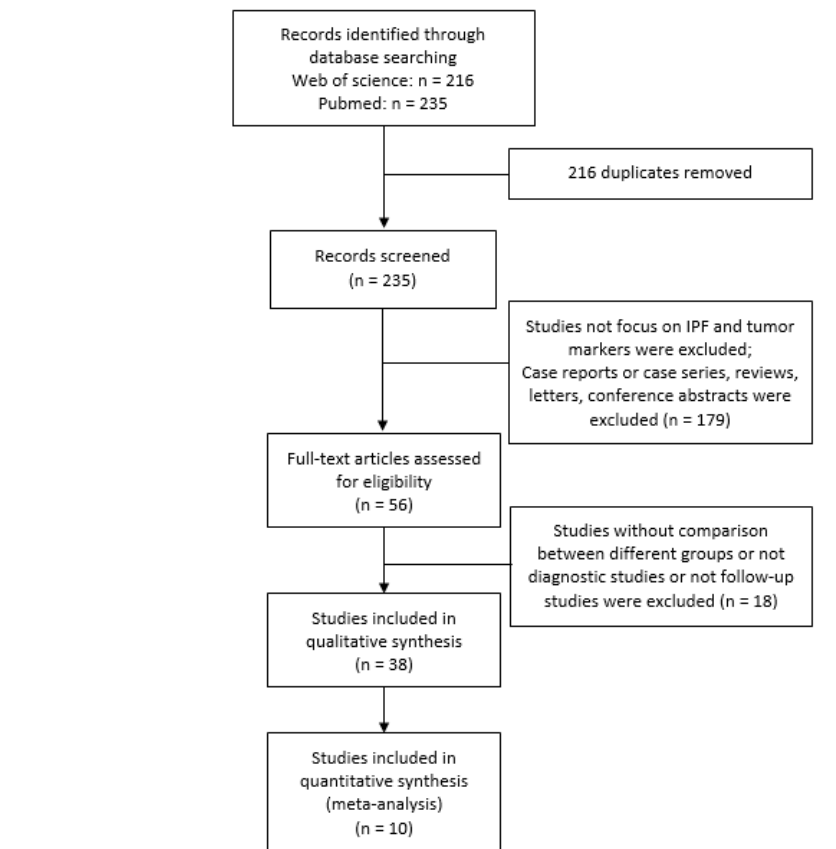
Figure 1. Flow diagram of chosen studies for the present metanalysis.